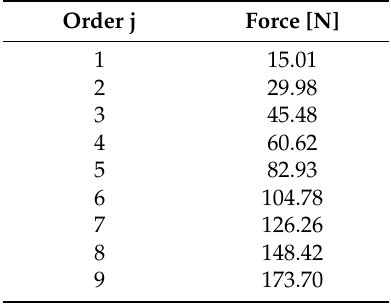
Figure 7. Vertical milling machine Kondia B 640 CNC.